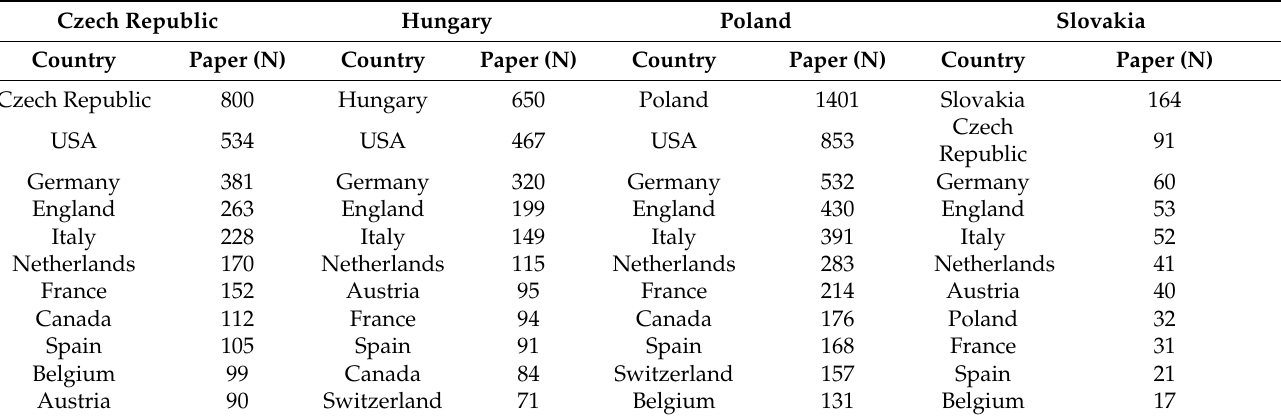
Table 4. The total number of Q1 papers coauthored by the top 10 countries for each V4